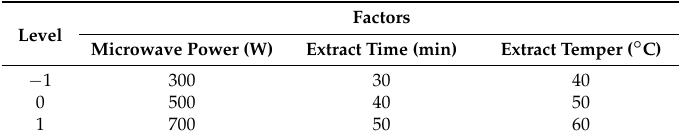
Table 5. Level and code of factors chosen for experiment.